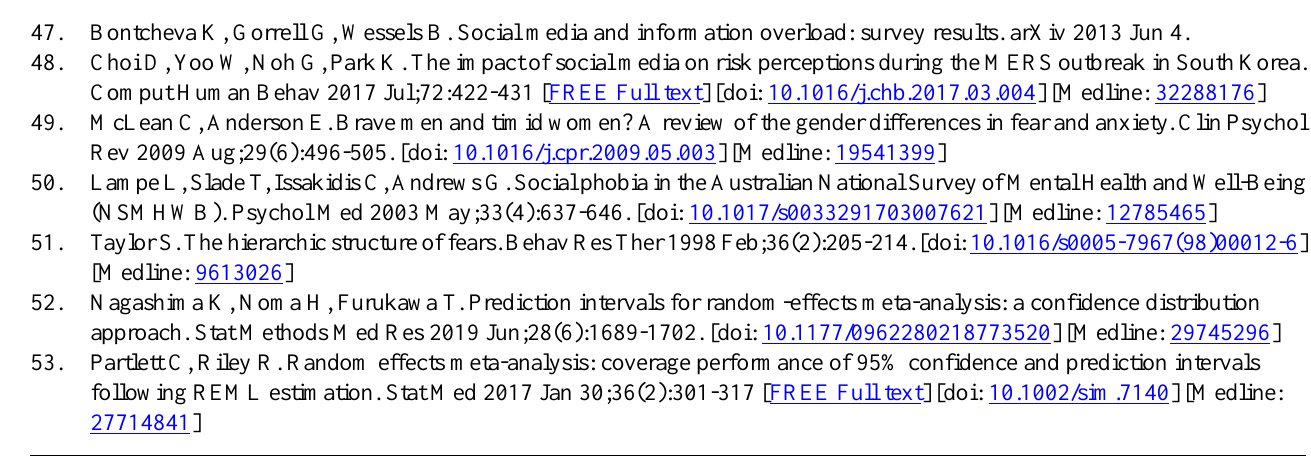
PRISMA: Preferred Reporting Items for Systematic Reviews and